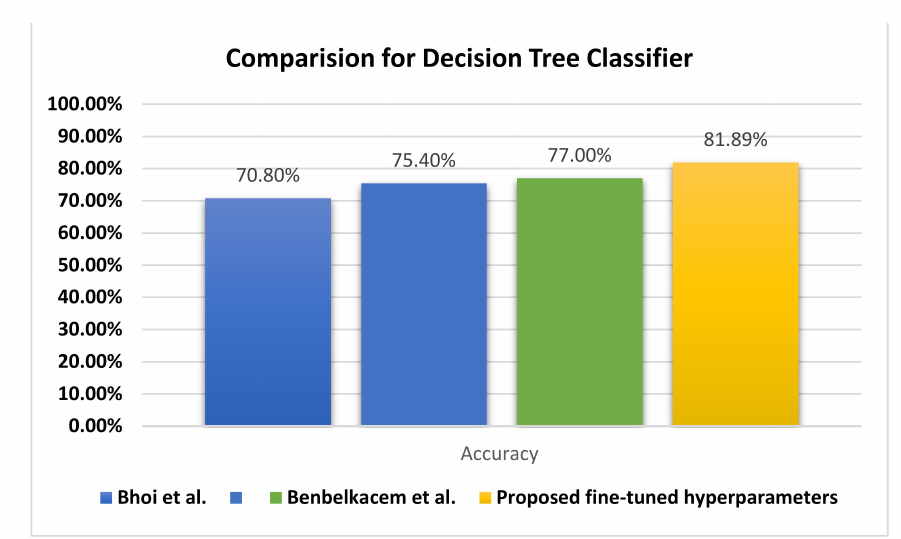
Figure 11. Comparative analysis of various configurations of decision tree algorithms using the PIDD.